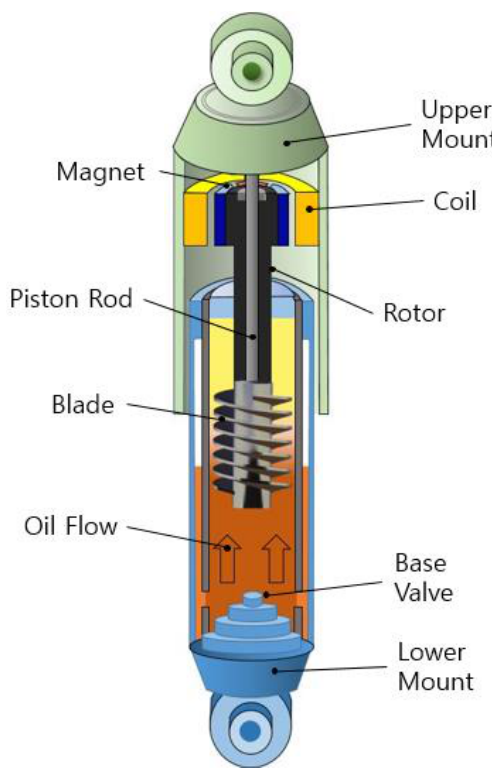
Figure 2. Cross-section of the suspension model used in this study.